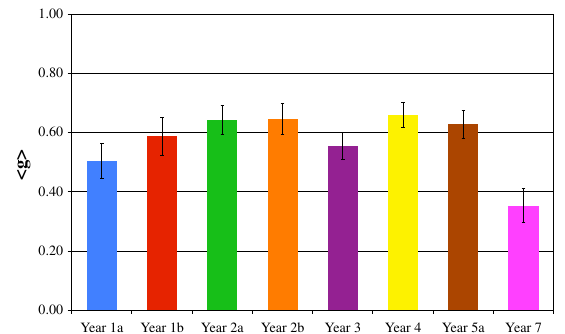
FIG. 5. FMCE normalized gain comparisons for school 2. Error bars are the standard error of the